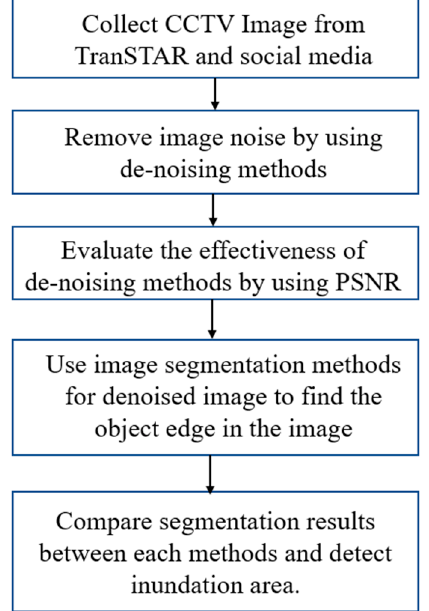
Figure 1. The basic flowchart of this study for inundation detection. (1) Collect closed-circuit television (CCTV) images from government websites or social media; (2) use four different de-noising filtering to find out which has the best de-noising quality, which evaluated by the peak signal-to-noise ratio (PSNR); (3) use image segmentation methods to understand how the computer interprets images and finds an edge which is the vital part for image object detection; (4) compare segmentation results between each method and detect inundation area.